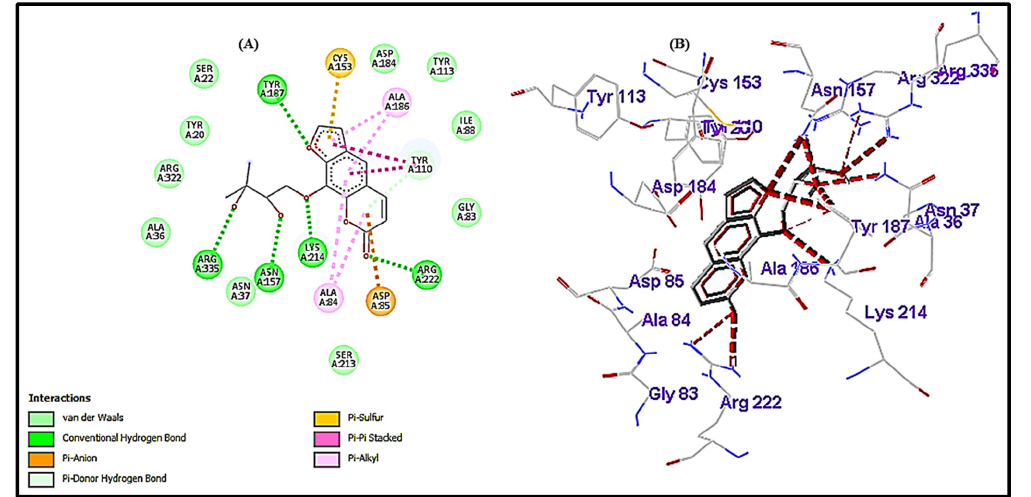
Figure 8. ( A ) The 2D plot of the interaction of heraclenol and HisC; hydrogen bonds are shown in green color lines. ( B ) Wireframe model of HisC with the heraclenol; red dotted lines represent the hydrogen bonds.